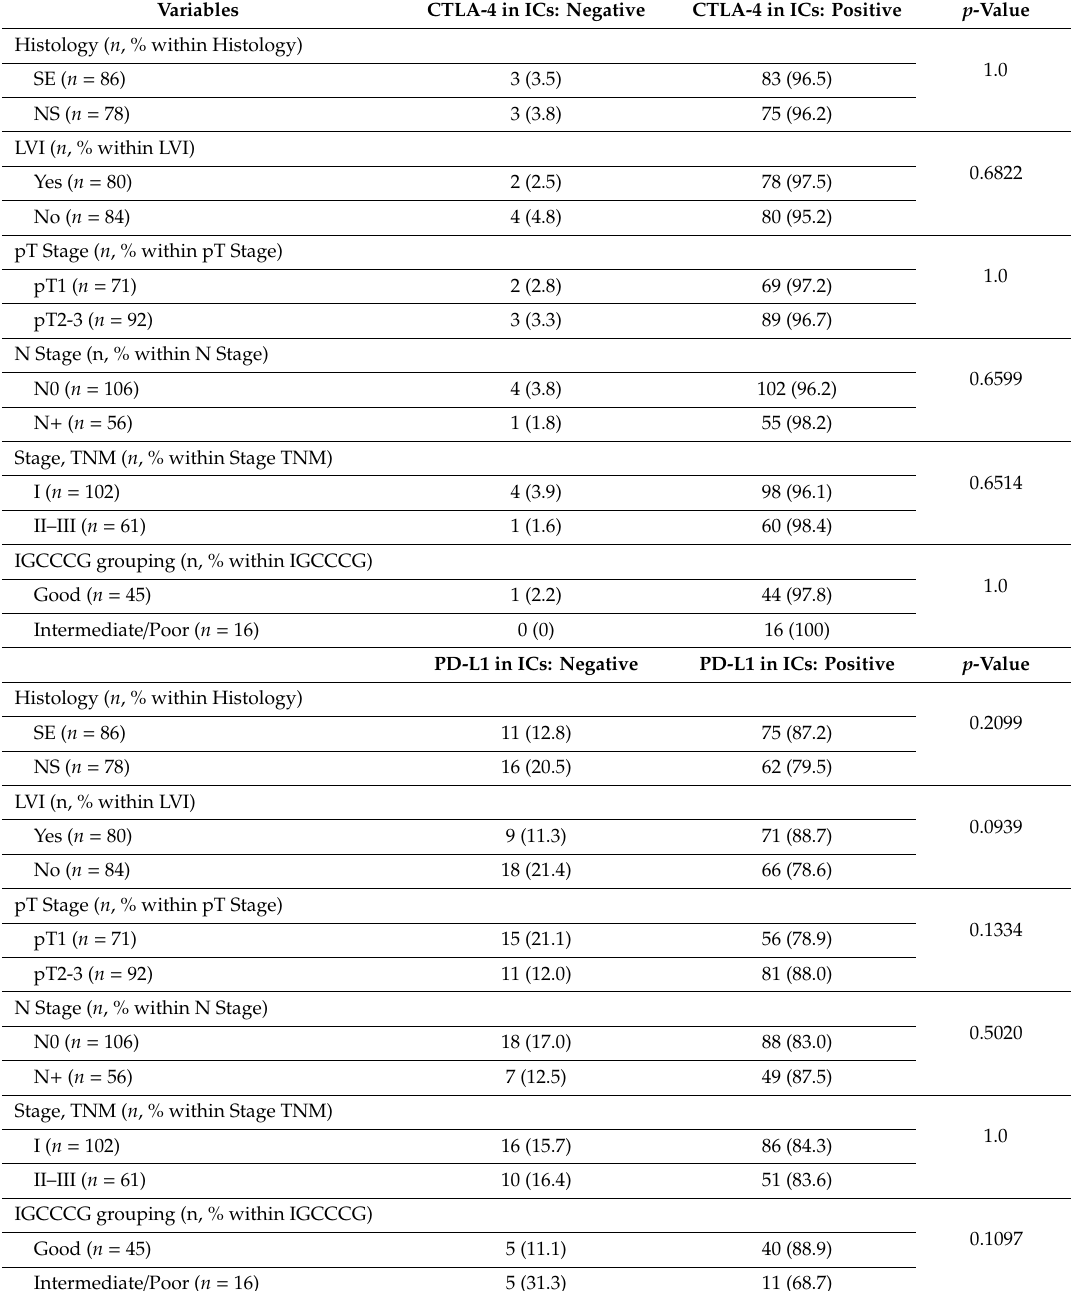
Table 2. Association between CTLA-4 and PD-L1 immunoexpression in immune cells and clinicopathological features. Variables CTLA-4 in ICs: